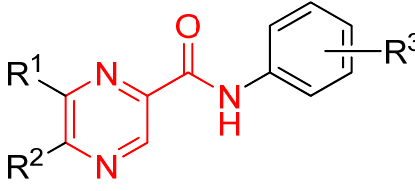
Figure 1. Pyrazinamide (red colour) structure modification (black